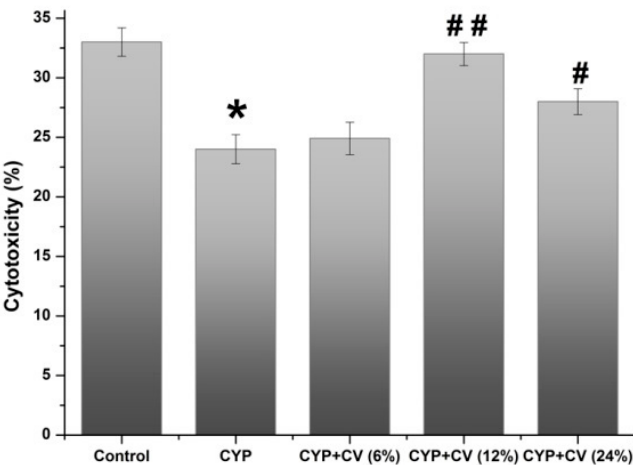
Figure 2. Effect of CV on the natural killer (NK) cell cytotoxicity in the CYP-treated mice. Note: Data were expressed as mean ± SD, *: only the CYP treatment was compared against the control treatment ( p < 0.05); #: only the CYP + CV treatment was compared against the CYP treatment ( p < 0.05), ##: only the CYP + CV treatment was compared against the CYP treatment ( p < 0.01).